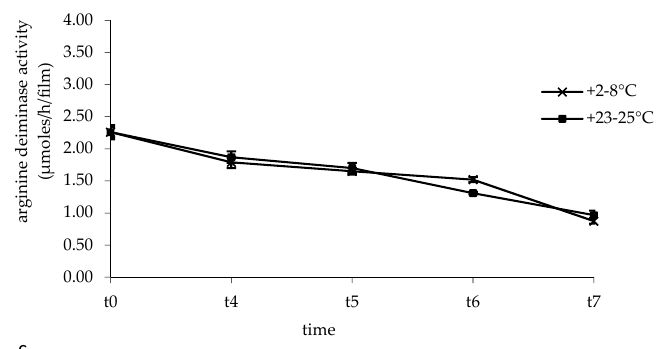
Figure 4. Arginine deiminase activity in the buccal films during the storage period of 48 weeks at the temperatures of +2–8 °C and +23–25 °C. t0: time zero; t4: 12 weeks; t5: 24 weeks; t6: 36 weeks; t7: 48 weeks. ( a ) Batch I; ( b ) batch II; ( c ) batch III. Data are expressed as mean of three measurements ± standard deviation.